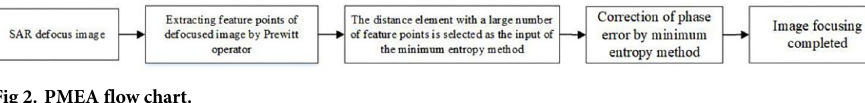
Fig 2. PMEA flow